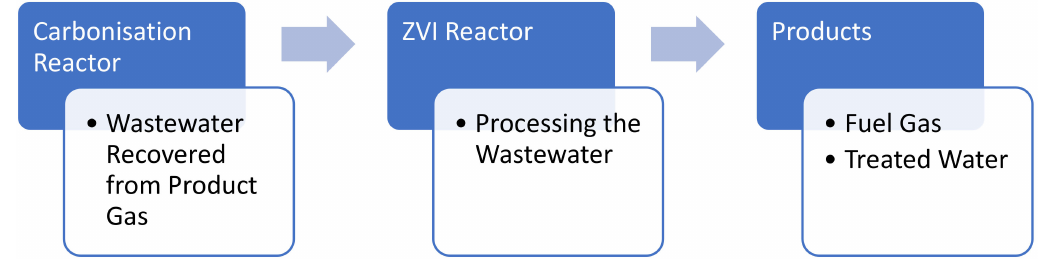
Figure 2. Conceptual process flow diagram for the ZVI process.